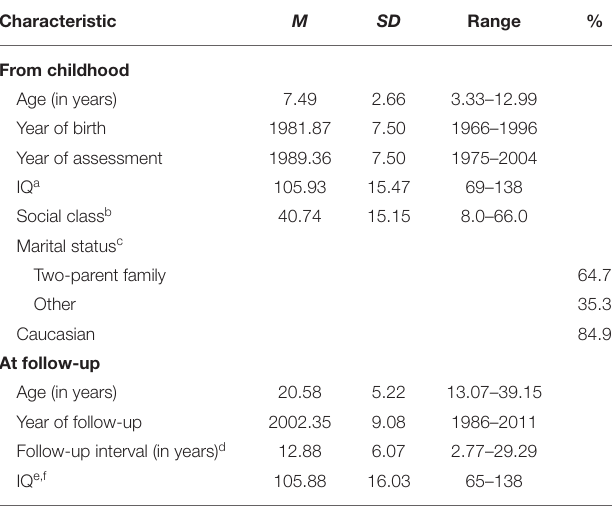
TABLE 1 | Demographic characteristics ( N =